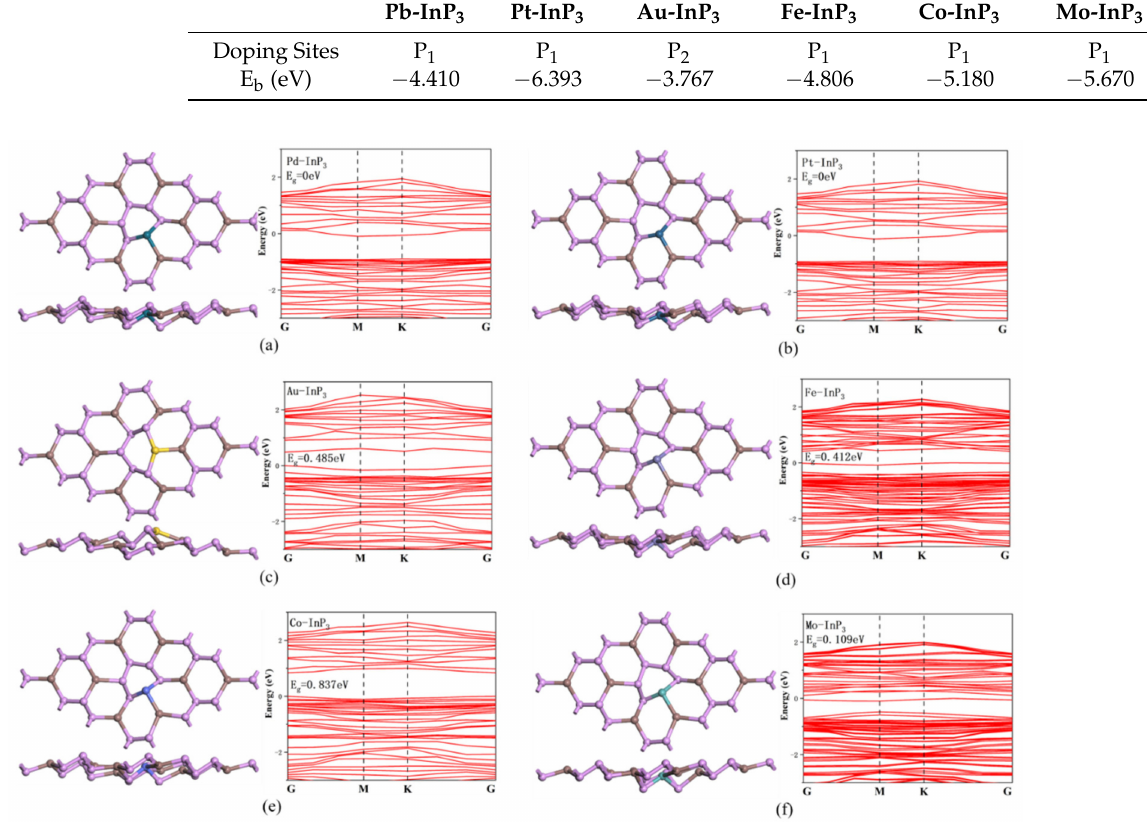
Figure 2. Structure and energy band of ( a ) Pd-InP 3 , ( b ) Pt-InP 3 , ( c ) Au-InP 3 , ( d ) Fe-InP 3 , ( e ) Co-InP 3 and ( f ) Mo-InP 3